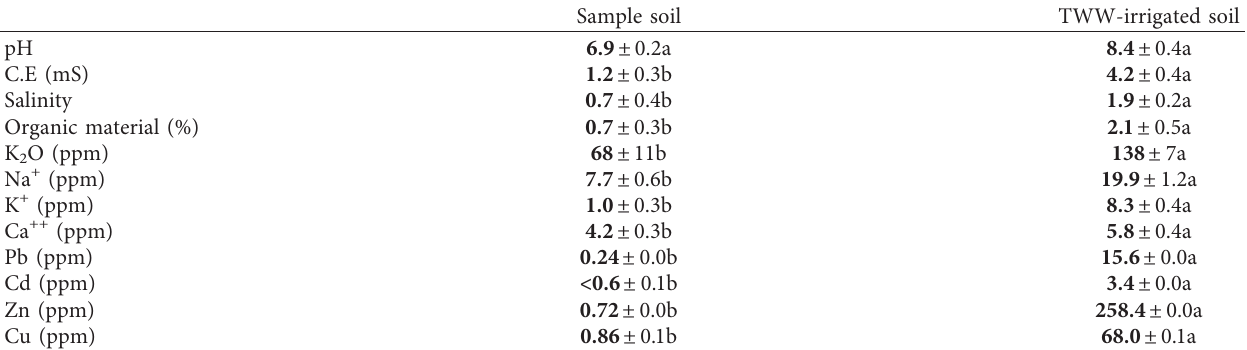
Table 1: Physical and chemical characteristics of control soil and wastewater irrigated soil. Sample